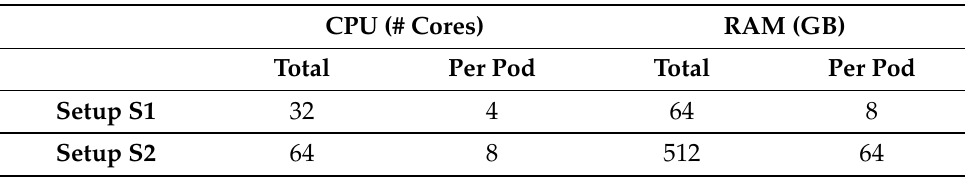
Table 4. H/W specs for